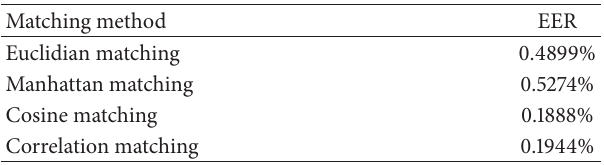
Table 1: Experimental result without image